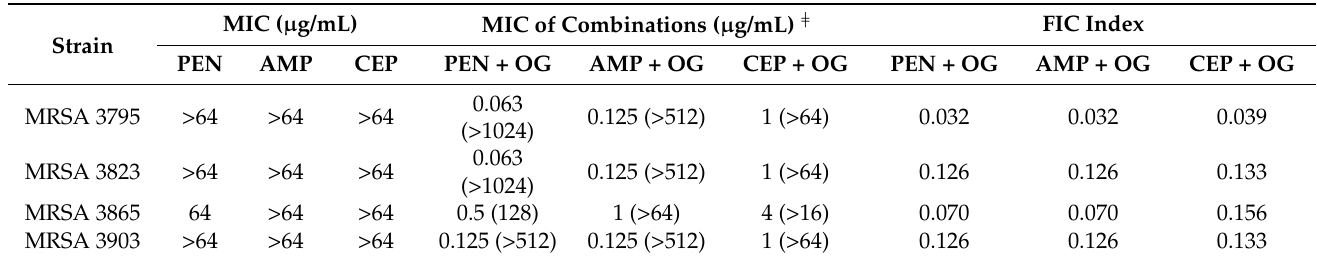
Table 2. MIC and FIC index of octyl gallate (OG) and β -lactam combinations against MRSA isolates Table 3. MBC and FBC index of octyl gallate (OG) and β -lactam combinations against MRSA isolates from clinical cases in humans. from clinical cases in humans.